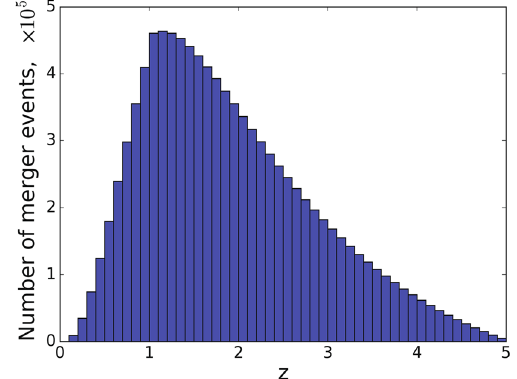
Fig. 4 The number of merger events in each redsshift bin of Δ z = 0.1 at a redshift z during 10-year observation